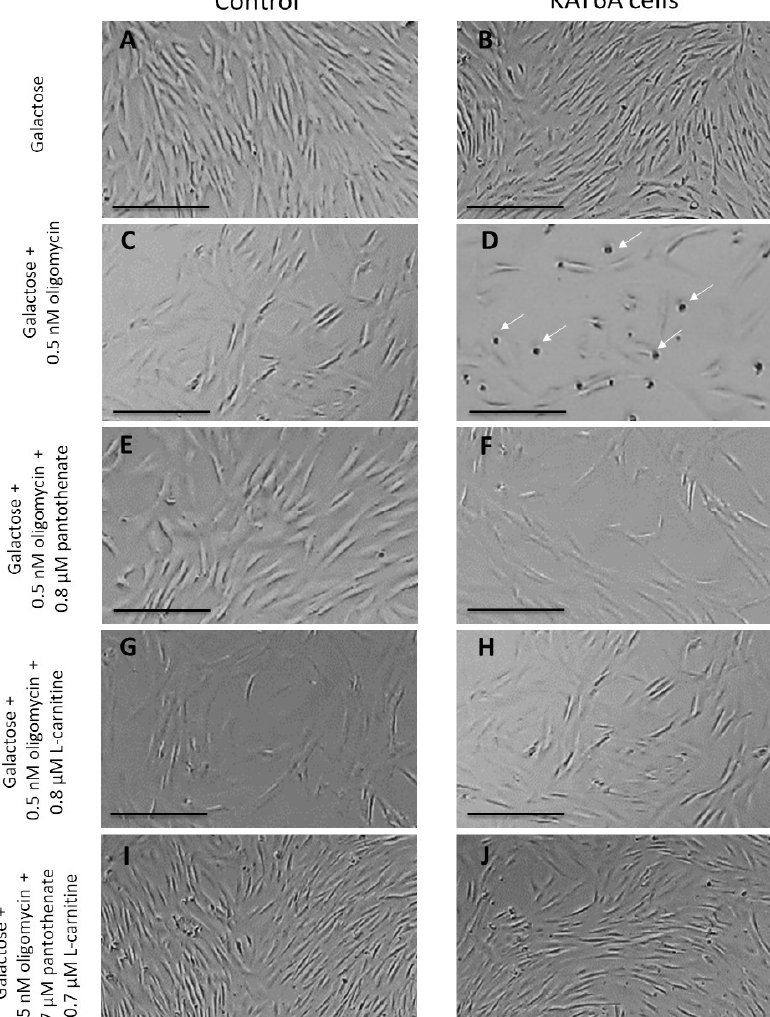
Figure 2. Pantothenate and L-carnitine supplementation increases cell survival in stress medium . First, Control (C1) and mutant KAT6A fibroblasts (P1) were cultured in DMEM high glucose. After 3 days, the glucose medium was replaced by a galactose medium with 0.5 nM oligomycin. Images were acquired right after changing the medium and after 72 h of incubation. ( A , B ) Control and mutant KAT6A fibroblasts in glucose medium. ( C , D ) Control and mutant KAT6A fibroblasts in stress medium. ( E , F ) Control and mutant KAT6A fibroblasts (P1) treated with 0.8 µ M pantothenate in stress medium. ( G , H ) Control and mutant KAT6A fibroblasts treated with 0.8 µ M L-carnitine in stress medium. ( I , J ) Control and mutant KAT6A fibroblasts (P1) treated with 0.7 µ M pantothenate and 0.7 µ M L-carnitine in stress medium. Data represent the mean ± SD of three separate experi- ments. The quantification of cellular proliferation rate is shown in Supplementary Figures S4–S6. Scale bar = 200 µ m. White arrows = dead